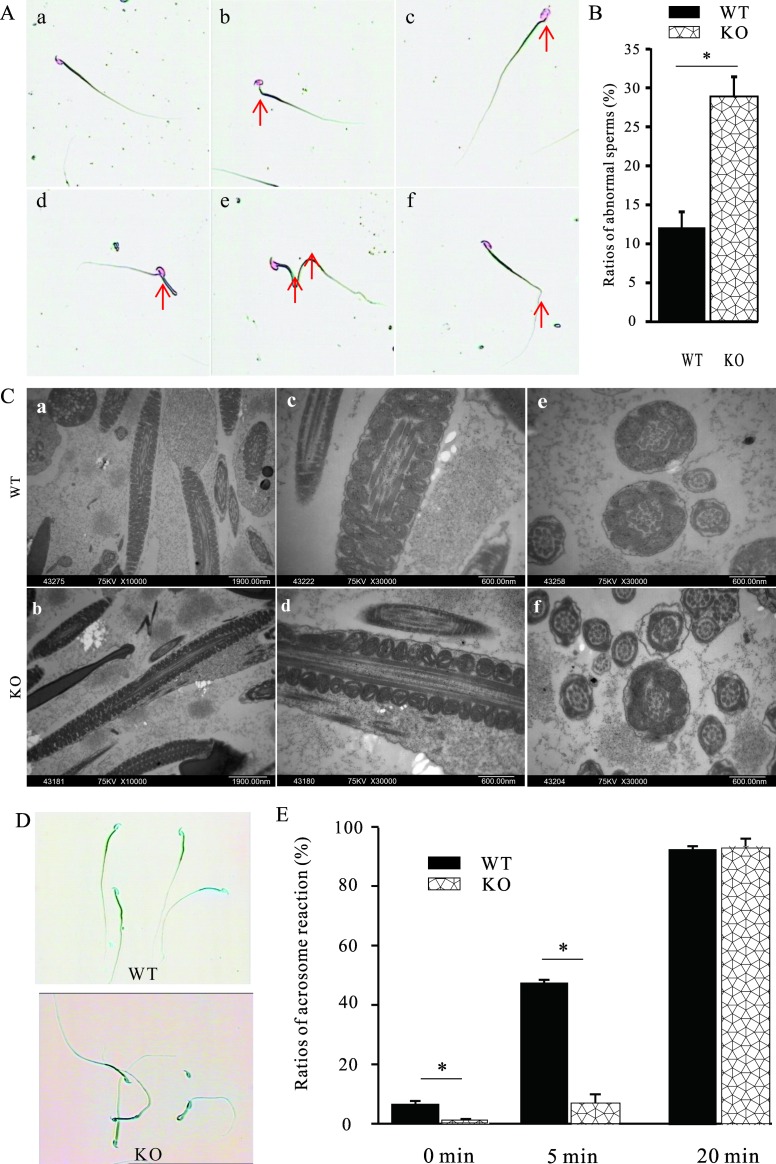
Both morphology and the acrosome reaction of sperm were impaired in MTMR14-/- mice.(A) Sperm with different structures. Sperm that are normal (a) or that have abnormal junction of the head and midpiece (b), abnormal heads (c), hairpin in the midpiece (d), hairpin in the principle piece (e), and hairpin in the tail (f) structure; red arrows indicate abnormal regions. (B) Statistical data of the proportions of abnormal sperm in WT and MTMR14-/- mice (n = 8). *: P < 0.05. (C) The ultrastructure of sperm tails in MTMR14-/- mice was subtly abnormal. Representative lengthwise images of the midpiece of elongating spermatids from WT at ×10,000 (a) and ×30,000 (c) and from MTMR14-/- mice at ×10,000 (b) and ×30,000 (d) and representative images of axonemes from epididymal sperm from WT at ×30,000 (e) and from MTMR14-/- mice are shown. In the KO mice, the membranes of epididymal sperm tails (f) expanded and creased. (D) Representative images of sperm that underwent acrosome reactions from WT and MTMR14-/- mice; characteristic light blue staining of the reacted acrosome is visible in WT mice, whereas in MTMR14-/- sperm, the acrosome reaction was barely found. (E) Statistical data of the proportions of sperm undergoing acrosome reactions at different time points after capacitation using calcium ionophore A23187. For each sample, at least 200 sperm were checked and counted. *: P < 0.05. These data suggested that MTMR14 plays an important role in regulating the fertilization ability of sperm in mice.